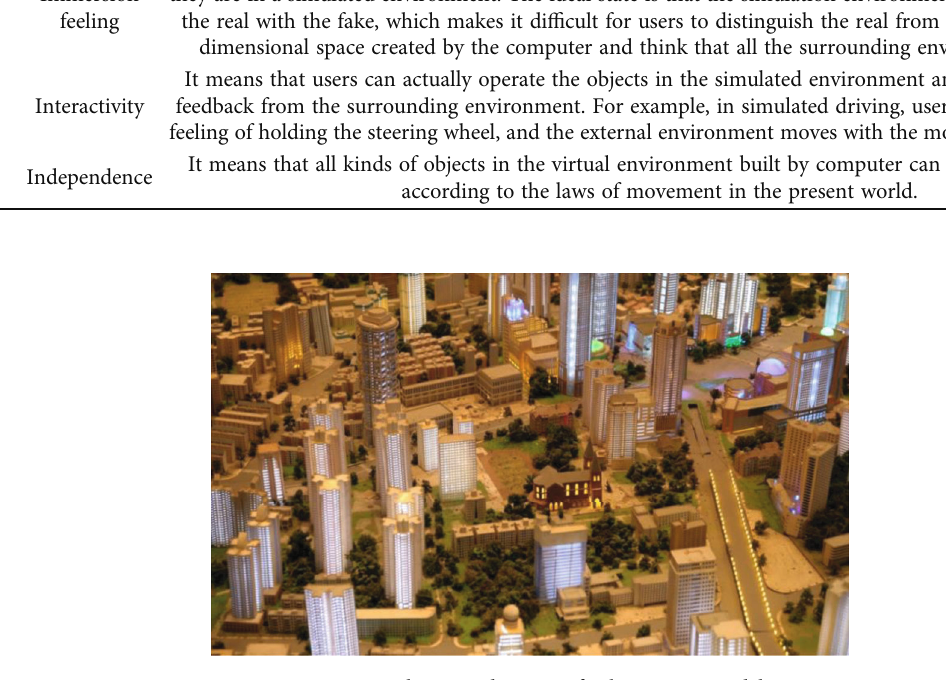
Figure 3: Schematic diagram of urban entity model.